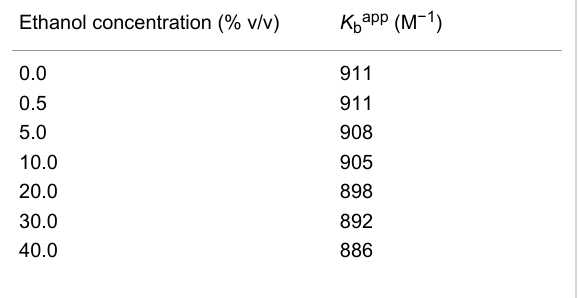
Table 3: The apparent binary complexation constant, K bapp , as a func- tion of ethanol concentration. Ethanol concentration (% v/v) K bapp (M − 1